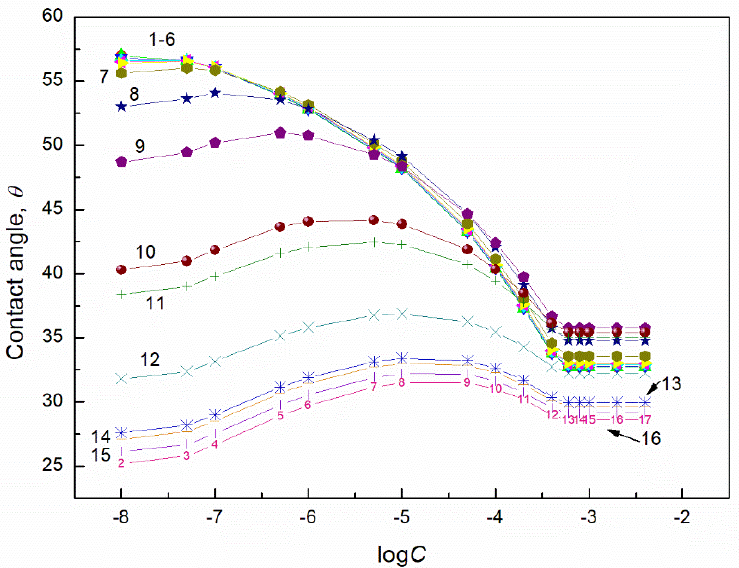
Figure 8. A plot of the contact angle ( θ ) of aqueous solution of TX165 + SF mixtures on the quartz surface vs. the logarithm of the TX165 concentration ( C ). Curves 1–16 correspond to the constant SF concentration equal to 0.0002, 0.0005, 0.00125, 0.003, 0.00625, 0.01, 0.02, 0.05, 0.1, 0.5, 1, 5, 10, 20, 30 and 40 mg/dm 3 , respectively.